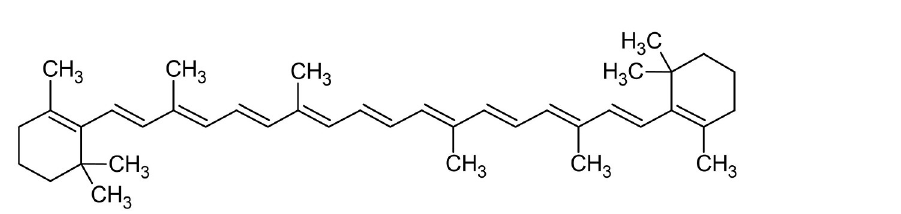
Fig 1. HPLC chromatogram of n-hexane of S . obliquus (A), and the yellow band containing β -carotene F1 (B).